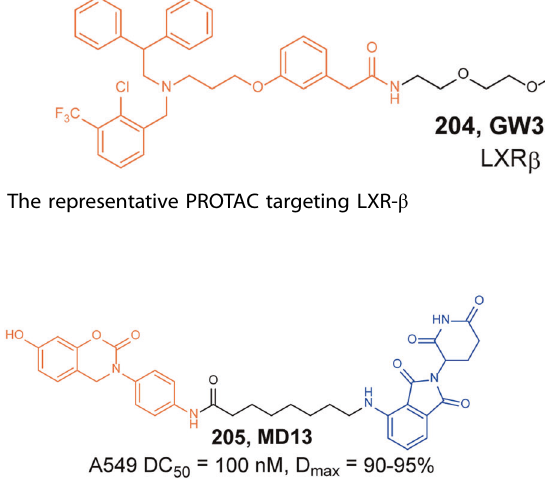
Fig. 60 The representative PROTAC targeting